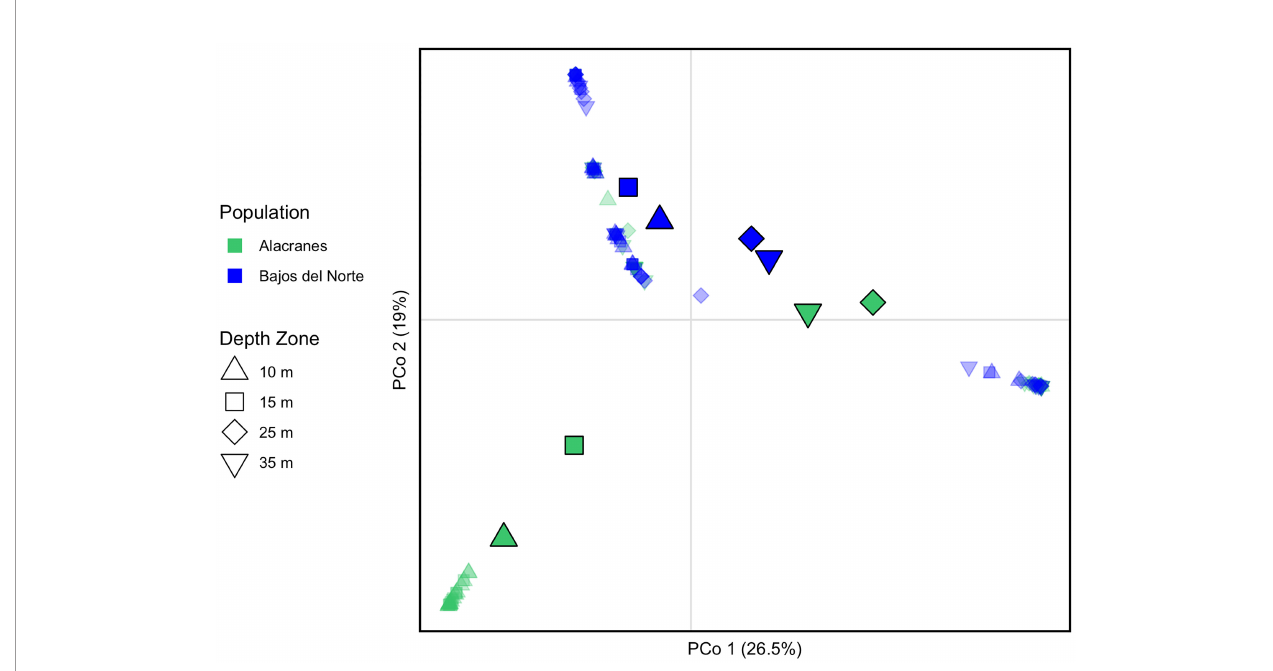
FIGURE 6 | Principal coordinates analysis based on Bray-Curtis distance matrix among samples ’ Symbiodiniaceae ITS2 type pro fi les. Individual samples are represented by small, transparent symbols and are jittered for visual clarity. Population centroids are indicated by larger, solid symbols. Color indicates reef and shape indicates depth zone of each sample and population centroid. The percent variation explained by each axis is